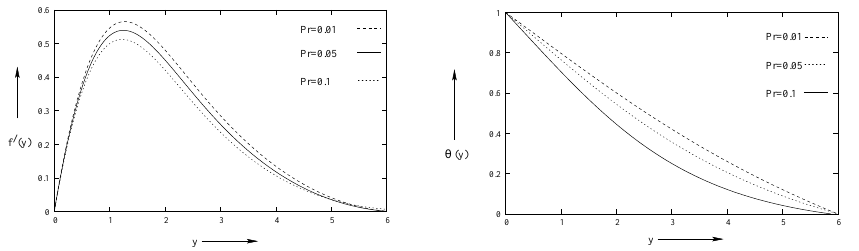
Figure 7. Variation of temperature with y for several values of Pr when a) k 1 = 0 . 5 , λ = 0